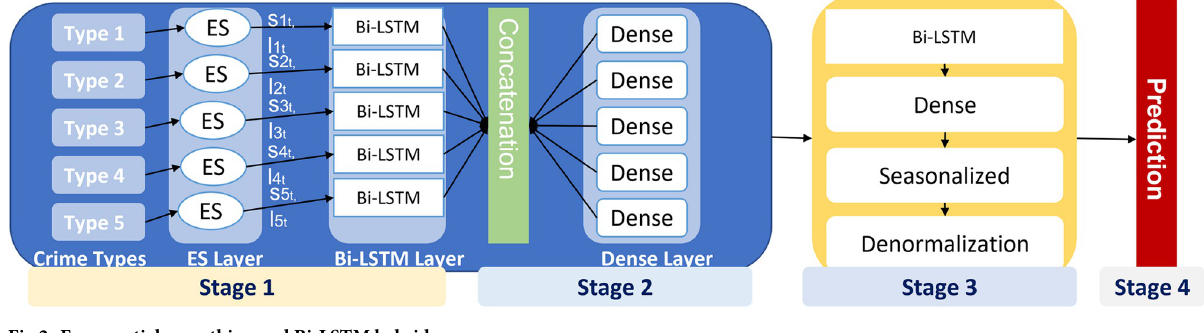
Fig 2. Exponential smoothing and Bi-LSTM